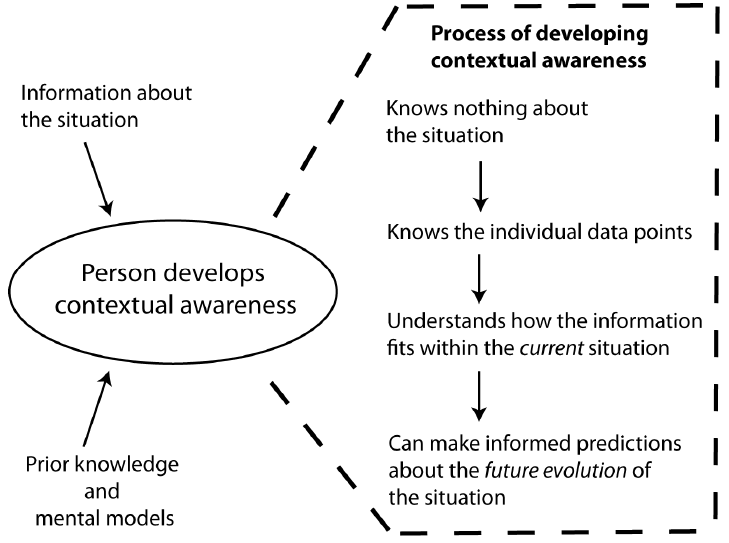
Figure 2. Stages of developing contextual